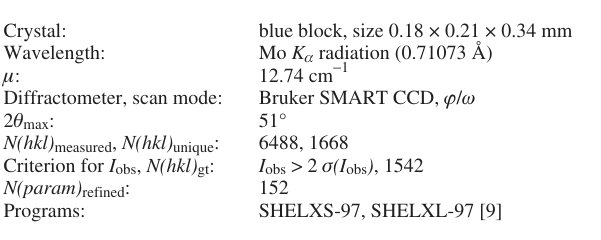
Table 1. Data collection and handling.